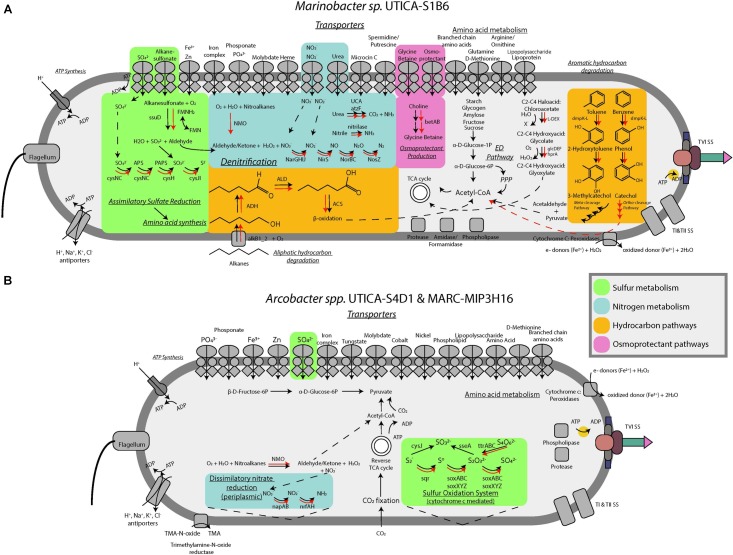
Conceptual metabolic models for (A)
Marinobacter and (B)
Arcobacter isolates incorporating isolate genomic (black arrows) and metagenome data (red arrows).